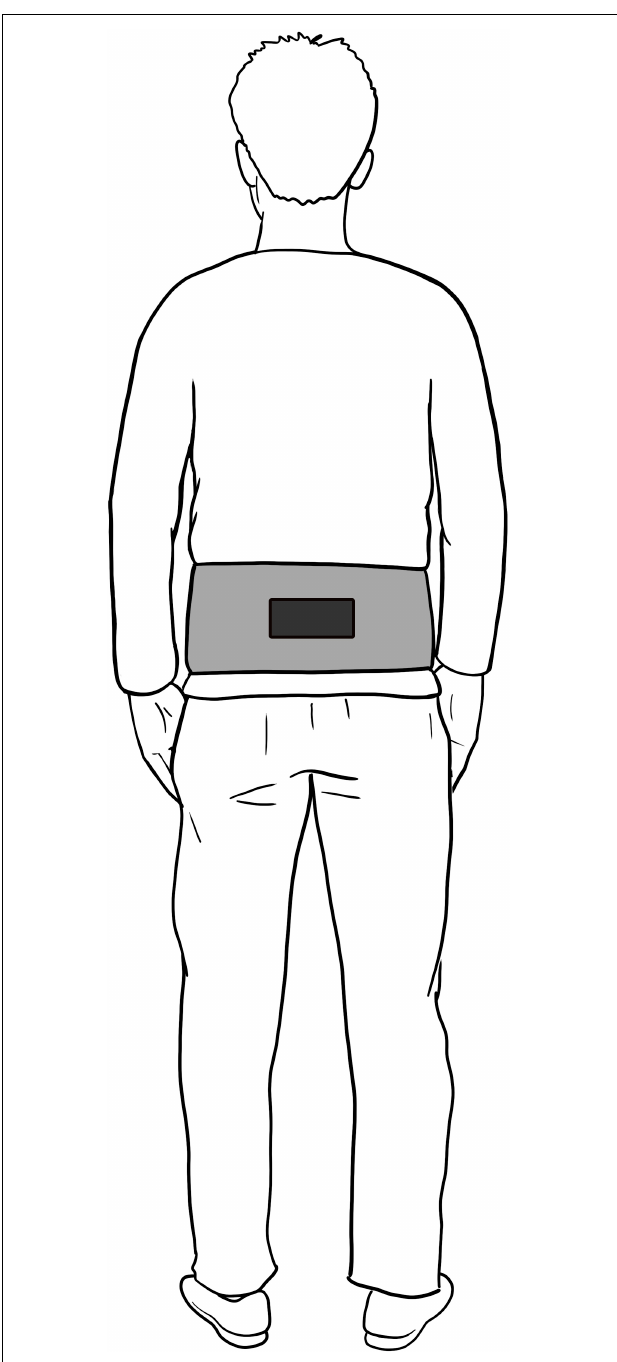
FIGURE 1 | Set up of Fallskip